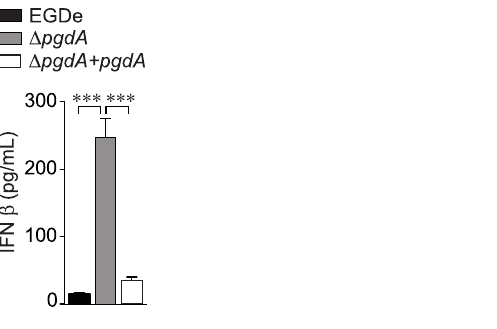
Figure 1. PgdA-dependent IFN- b response to Listeria in peritoneal macrophages. PEM from WT C57BL/6J mice were infected with the parental EGDe strain (black bars), the D pgdA mutant (grey bars) or the complemented D pgdA strain (white bars). After 7 h of infection, IFN- b levels were measured in supernatants by ELISA. Data are mean 6 SD (***, p , 0.0001, n =5).